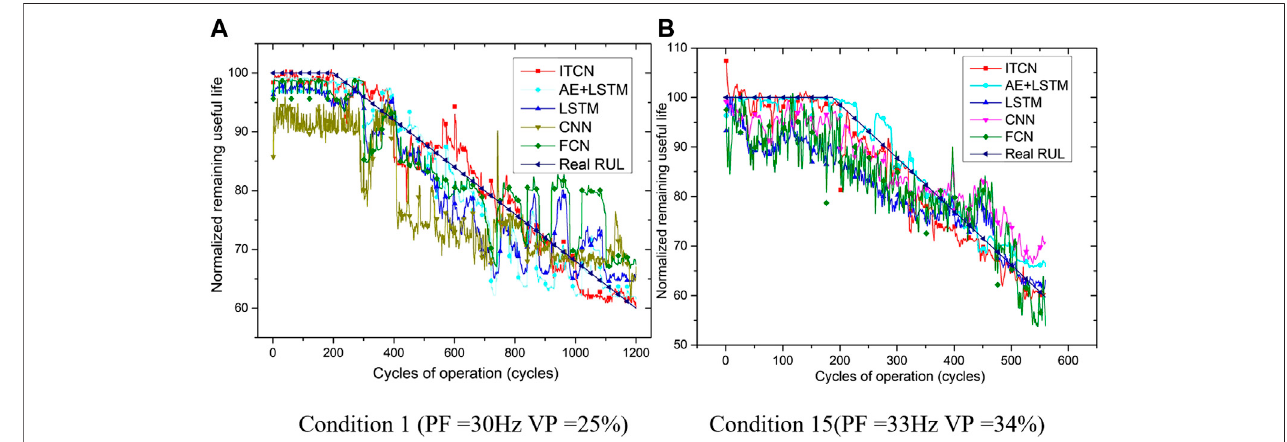
FIGURE 7 | RUL results with different algorithms.